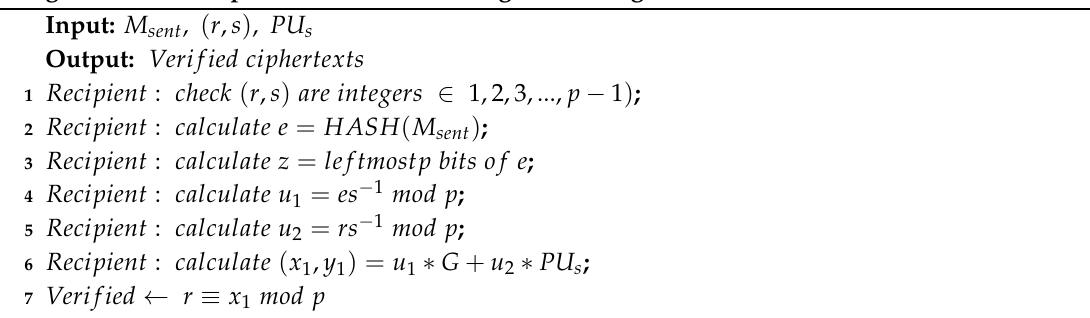
Algorithm 12: Recipient verification of a signed message.